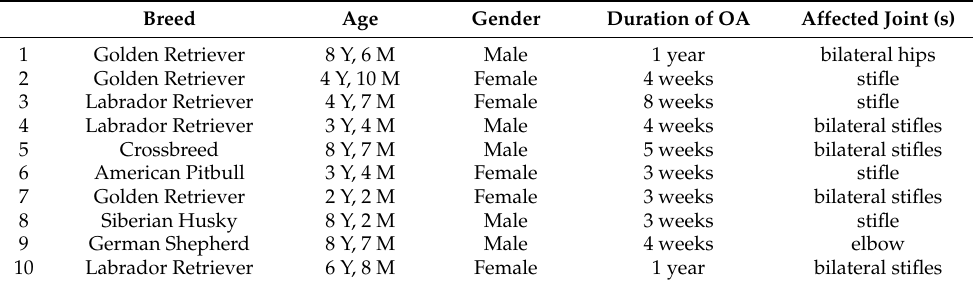
Table 1. Demographic data of study